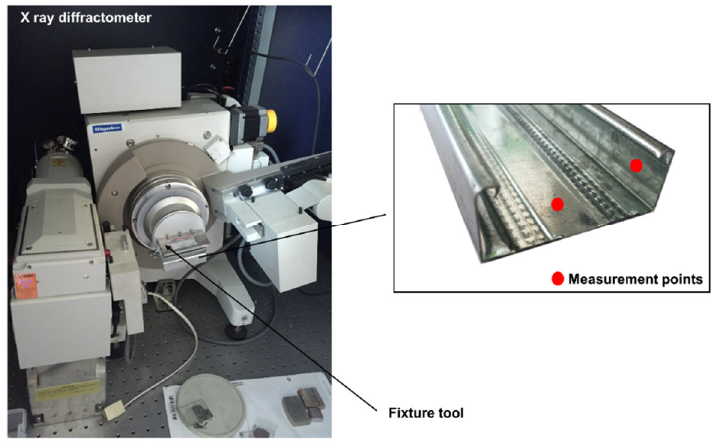
Figure 3. Residual measurement device and measurement locations on the specimen. Table 3. Measurement parameters of residual stress.